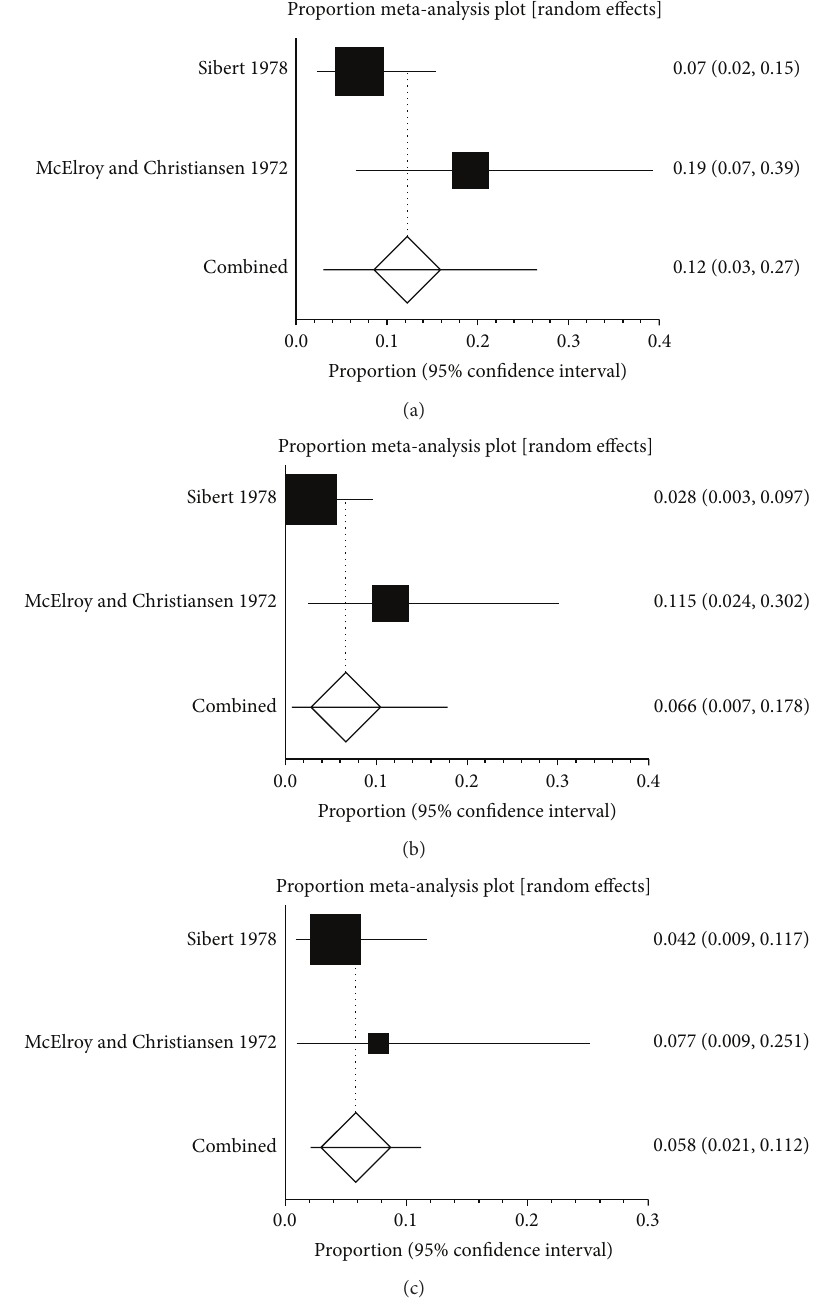
Figure 6: (a) Forest plots showing the prevalence of splanchnic vein thrombosis (SVT) in hereditary pancreatitis (HP). (b) Forest plots showing the prevalence of portal vein thrombosis (PVT) in hereditary pancreatitis (HP). (c) Forest plots showing the prevalence of splenic vein thrombosis (SlpVT) in hereditary pancreatitis